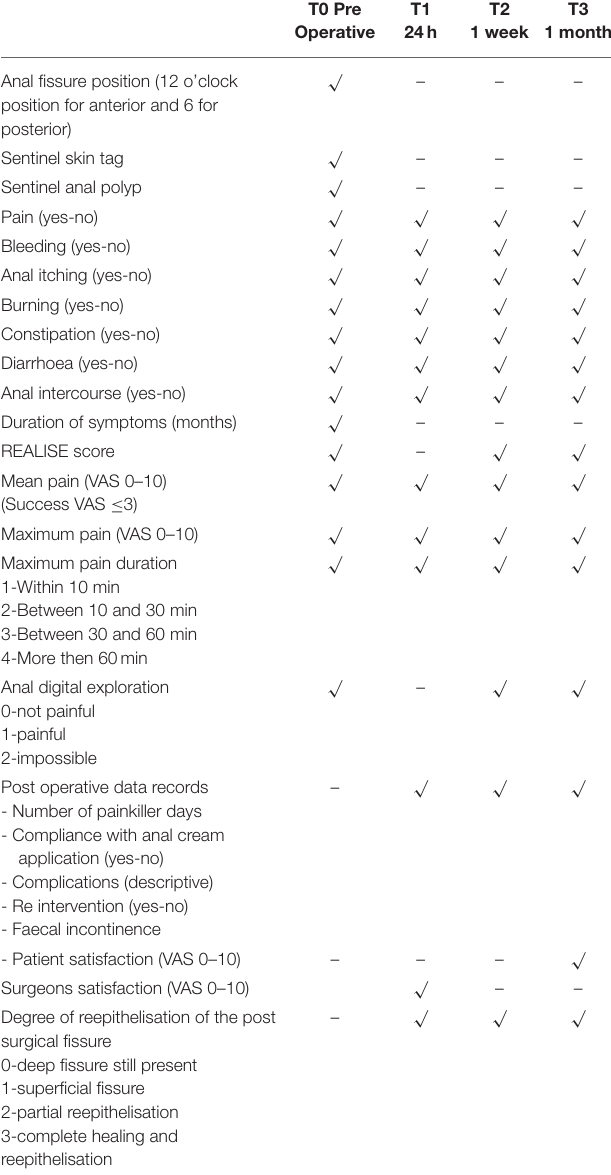
TABLE 1 | Data collection.